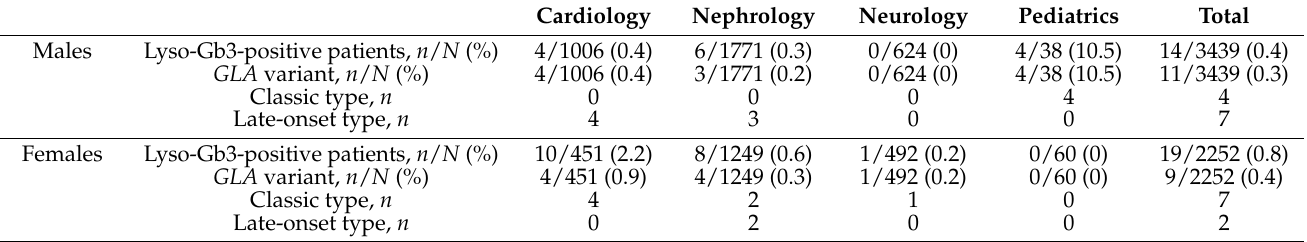
Table 3. Frequencies of patients who screened positive for lyso-Gb3 and class 1 GLA variants, grouped according to the specialty of the referring clinic.